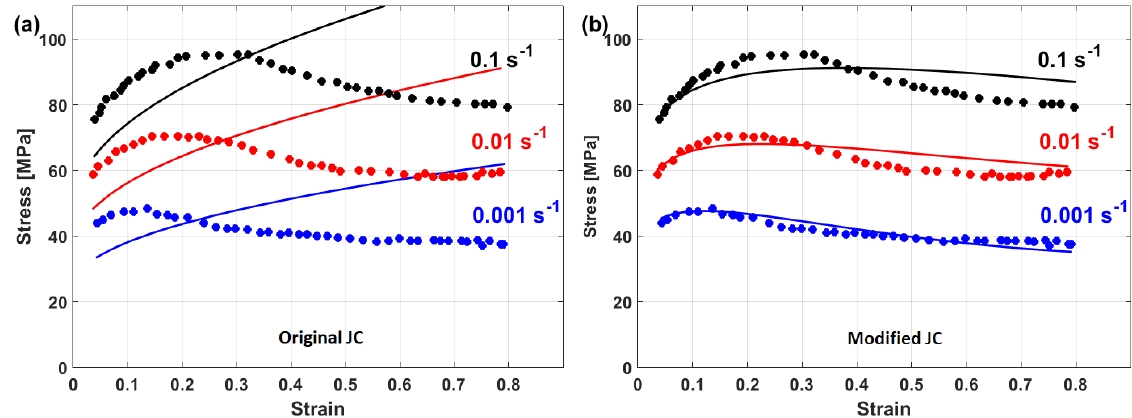
Figure 40. Experimental stresses (solid lines) compared to predicted stresses (markers) for 10%Cr steel alloy under hot deformation using ( a ) the original JC model and ( b ) the modified JC model that was presented by He et al.